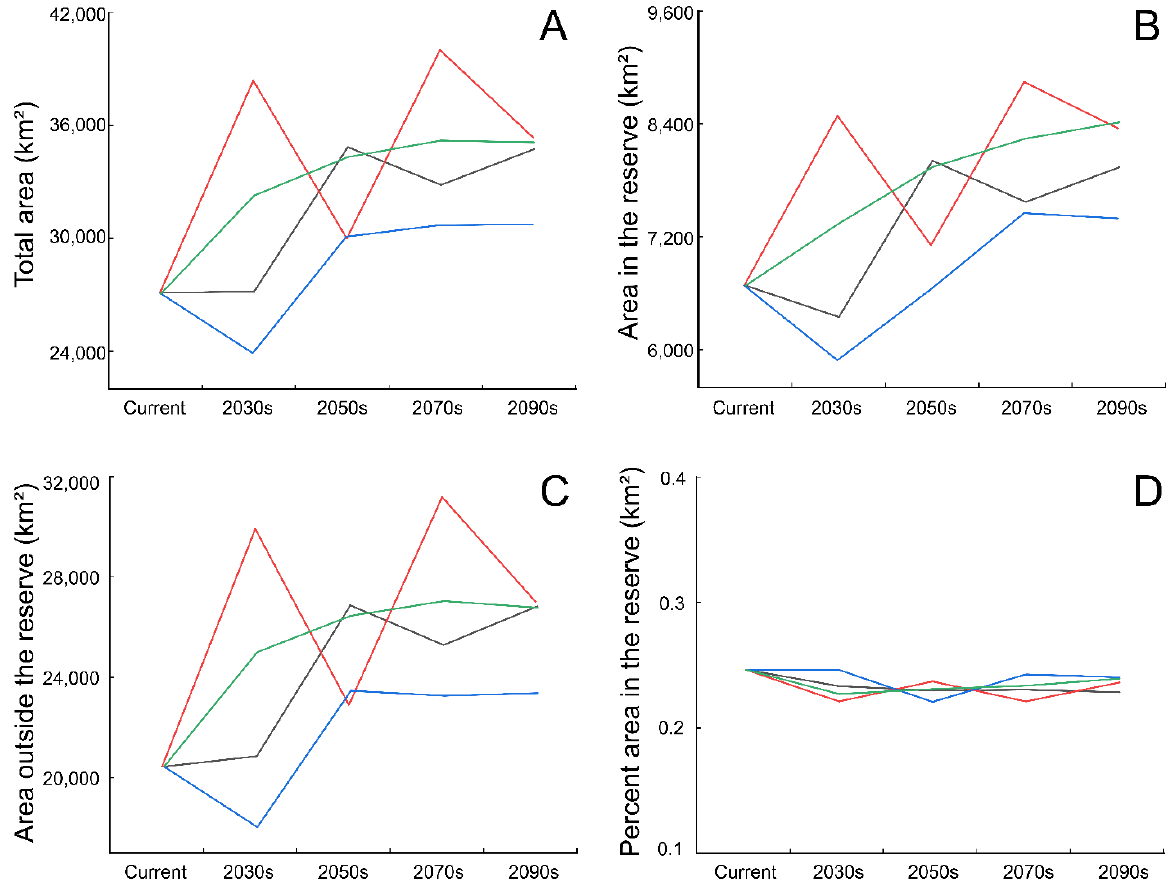
Figure 6. Effects of climate change on the total suitable habitat area ( A ), the suitable area within the protected area ( B ), the suitable area outside the protected area ( C ), and the proportion of protected area ( D ) for black-necked cranes in the Shaluli Mountains, under shared socio-economic pathway SSP1-2.6 (black lines), SSP2-4.5 (red lines), SSP3-7.0 (blue lines) and SSP5-8.5 (green lines).